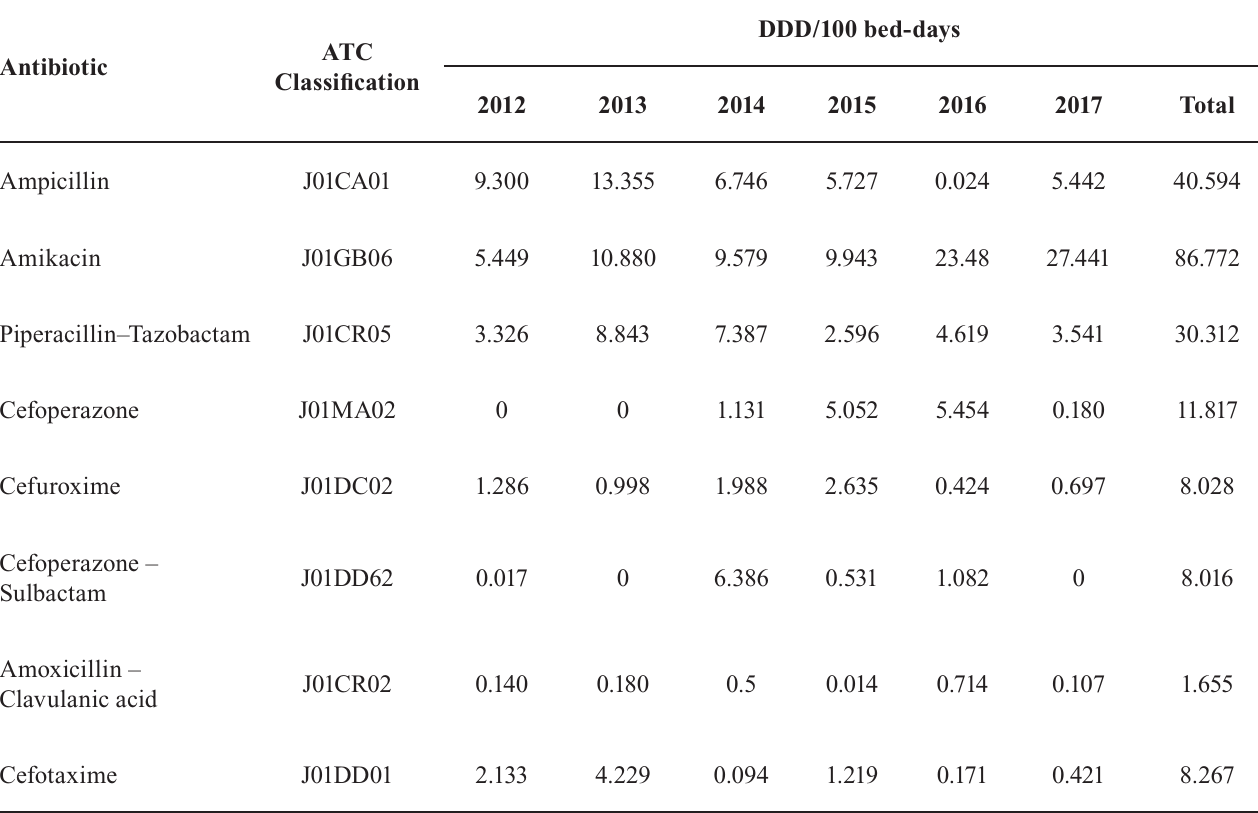
TABLE I - MKN45 xenograft tumors on day 12 after initial treatment (Volume & Net weight)